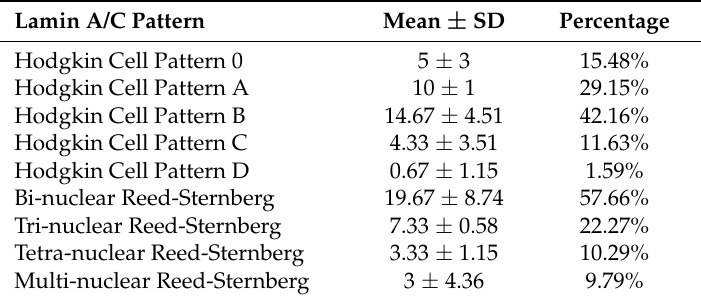
Table 1. Means and frequencies of the lamin A/C 3D pattern observed in cHL-derived cell line HDLM-2. 30 H and 30 RS cells from three independent experiments were analyzed using the deconvoluted 3D reconstructions and divided according to the lamin A/C 3D pattern shown.